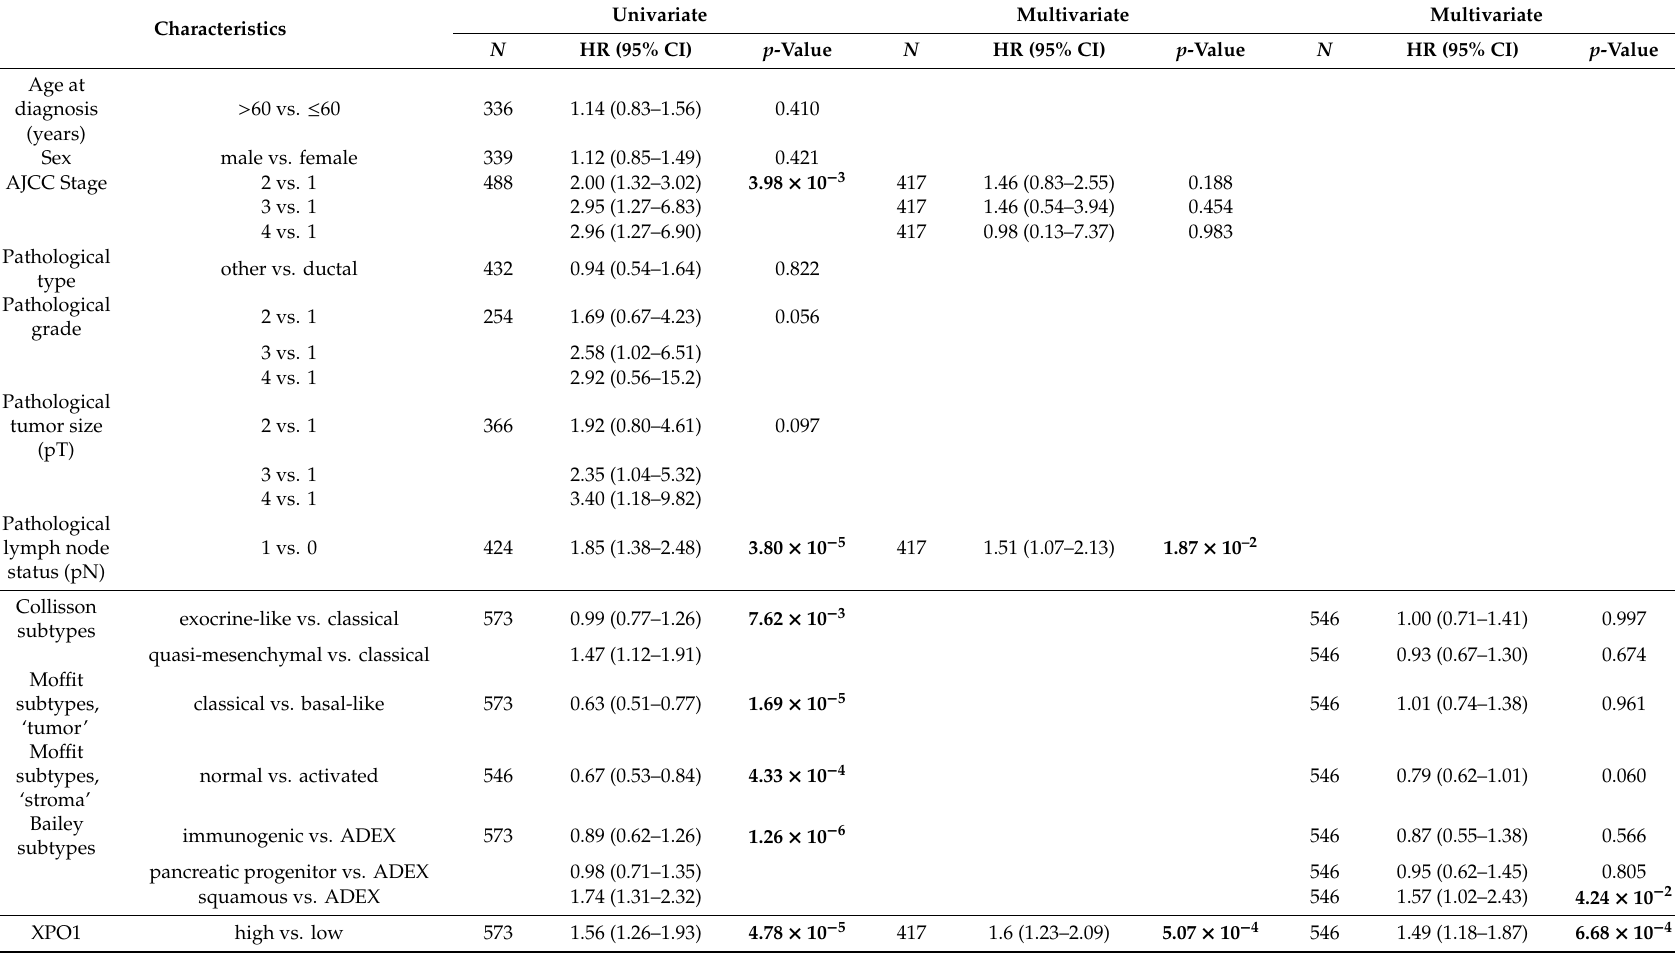
Table 2. Uni- and multivariate prognostic analyses for